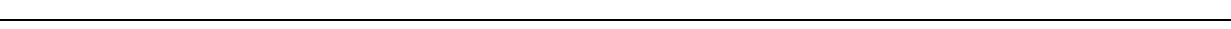
Fig. 5 Arf6 – AMAP1 pathway via ILK negatively regulates RhoT1 – TRAK2 interaction for ef fi cient distribution of mitochondria. a – c MDA-MB-231 cells were transfected with siRNA targeting TRAK1 or TRAK2. Protein expression of TRAK1 or TRAK2 was analyzed by western blotting ( a ). Mitochondria (green), microtubules (red), and nuclei (blue) were fl uorescently visualized by speci fi c antibodies or dyes. Bar, 10 μ m ( b ). Mitochondrial distribution was quanti fi ed ( c ). d – f MDA-MB-231 cells were transfected with siRNA targeting AMAP1, Arf6, ILK, TRAK1, or TRAK2, in the combinations indicated. Expression of each protein was analyzed by western blotting ( d ). Mitochondria (green), microtubules (red), and nuclei (blue) were fl uorescently visualized by speci fi c antibodies or dyes. Bar, 10 μ m ( e ). Mitochondrial distribution was quanti fi ed ( f ). g , h MDA-MB-231 cells stably expressing V5-RhoT1 were serially transfected with the indicated siRNAs and then plasmid DNA encoding Xpress-tagged TRAK1 or TRAK2. Parental cells were also used as a control. Immunoprecipitation by the anti-V5 antibody was performed using lysates of the cells expressing Xpress-TRAK1 ( g ) or TRAK2 ( h ). Asterisks indicate non- speci fi c bands. ( i ) Immunoprecipitation using lysates of MDA-MB-231 cells transfected with the indicated siRNAs, and the anti-ILK antibody. j – l MDA-MB- 231 cells were transfected with siRNA targeting TRAK1 or TRAK2. ROS production was visualized by DHE ( j ), and quanti fi ed ( k ). Bar, 50 μ m. Cumulative cell death after IR treatment was also measured ( l ). All graphs indicate the mean ± SEM of three independent experiments. * and # P < 0.05; ** and ## P < 0.005 (two-tailed t -test, adjusted by the Holm – Sidak method). * and **, comparison to si-NC samples; # and ## , comparison to the corresponding samples (i.e., si-AMAP1 + si-NC vs. si-AMAP1 +